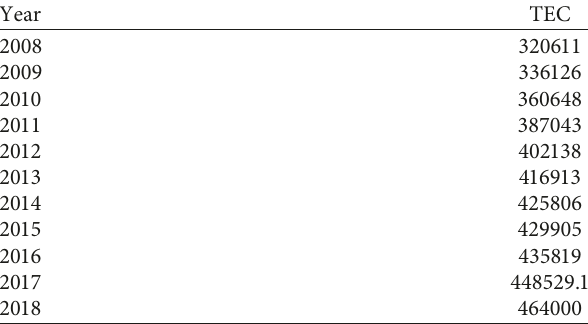
Table 7: The raw sequence of China’s total energy consumption (TEC) (2008–2018).